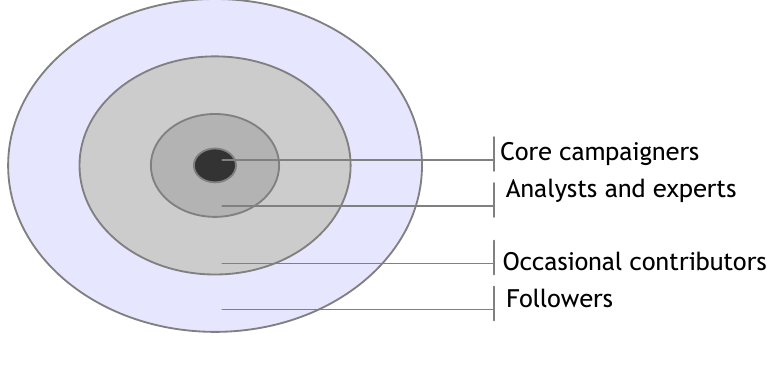
Figure 1: Concentric circles of